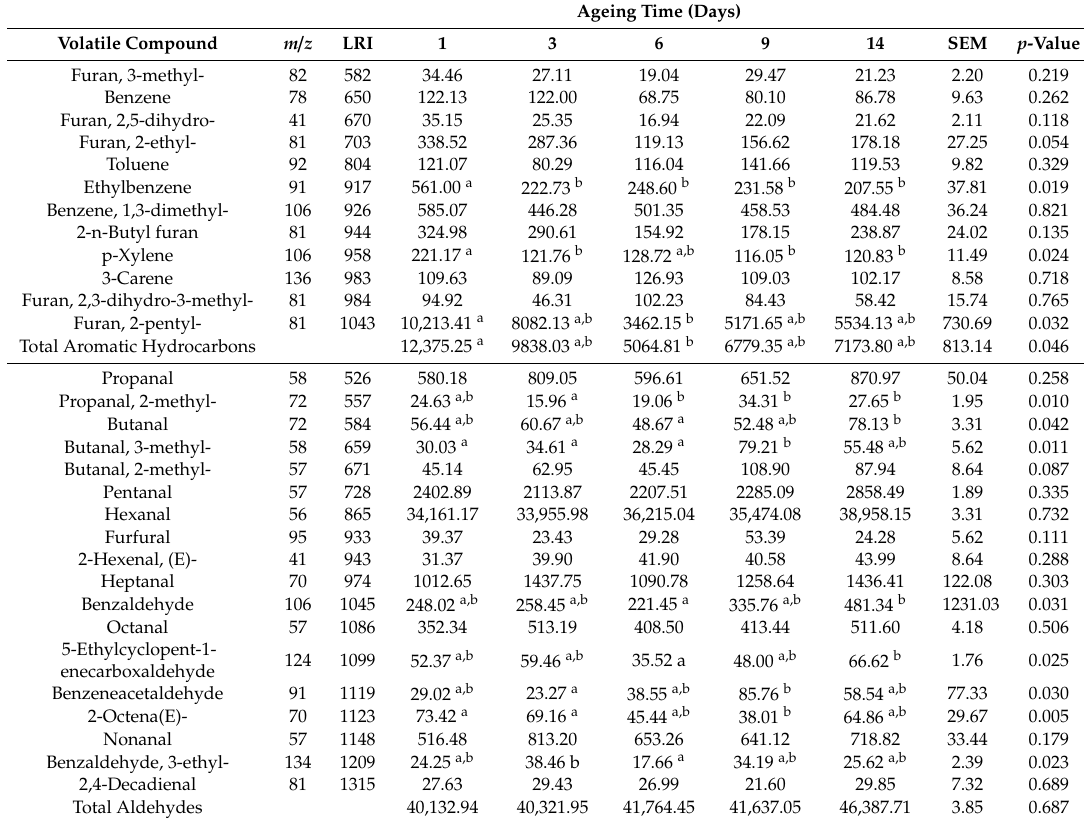
Table 1. E ff ect of aging time in aromatic hydrocarbons and aldehydes content, expressed as quantifier area units (AU × 10 3 / g), of donkey meat steaks aged for 14 days under vacuum conditions ( n = 10 samples for each aging time).